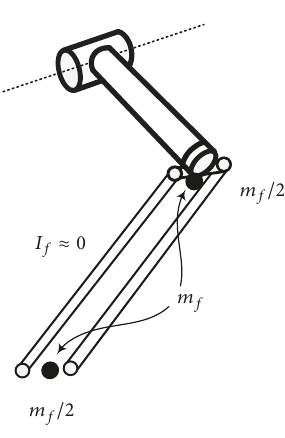
Figure 3: Splitting the forearm mass into two